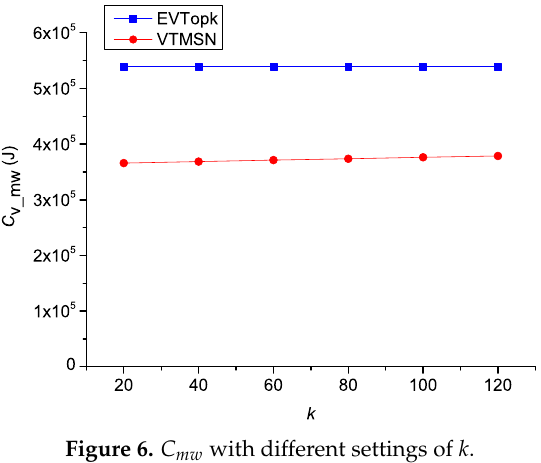
Figure 6. C mw with different settings of k .